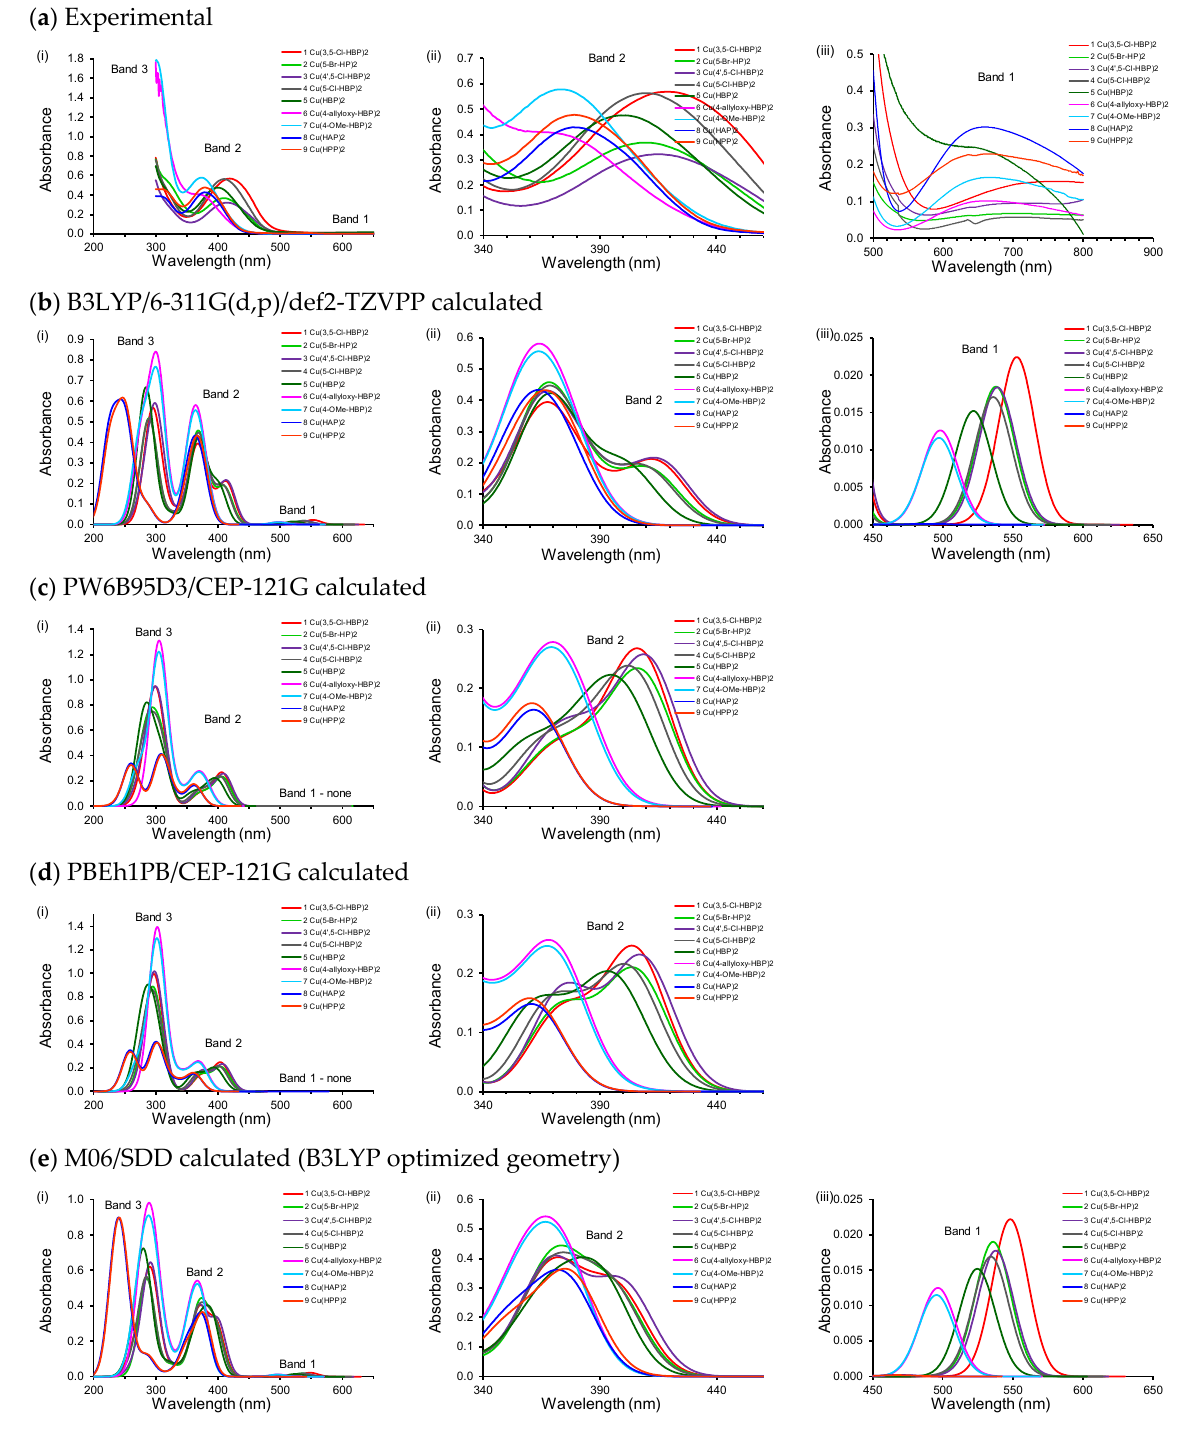
Figure 2. ( a ) Experimental absorption spectra of the Cu(II) complexes ( 1 )–( 9 ) in DMSO in region ( i ) 300–650 nm, ( ii ) 340–450 nm and ( iii ) 500–800 nm; ( b – e ): Simulated absorption spectra of the Cu(II) complexes ( 1 )–( 9 ), calculated with the ( b ) B3LYP/6-311G(d,p)/def2-TZVPP, ( c ) PW6B95D3/CEP-121G, ( d ) PBEh1PB/CEP-121G and ( d ) M06/SDD methods, all using DMSO as implicit solvent.